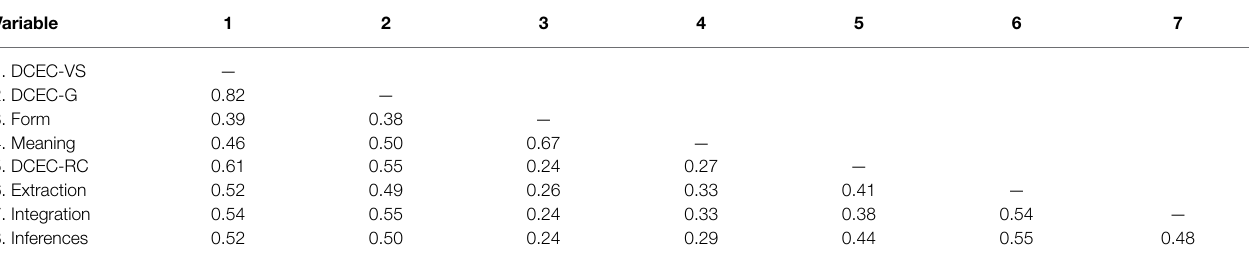
TABLE 3 | Correlations among all examined variables ( N = 1,149). Variable